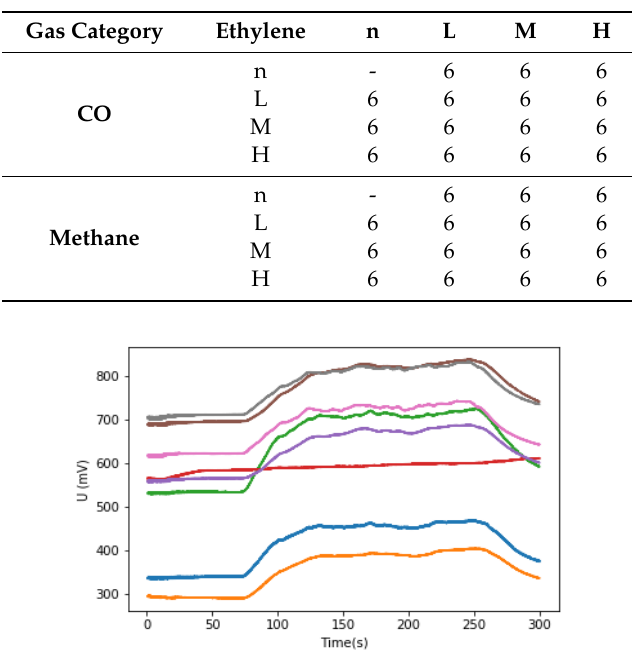
Figure 5. Et_H_Me_n sensor response curve.